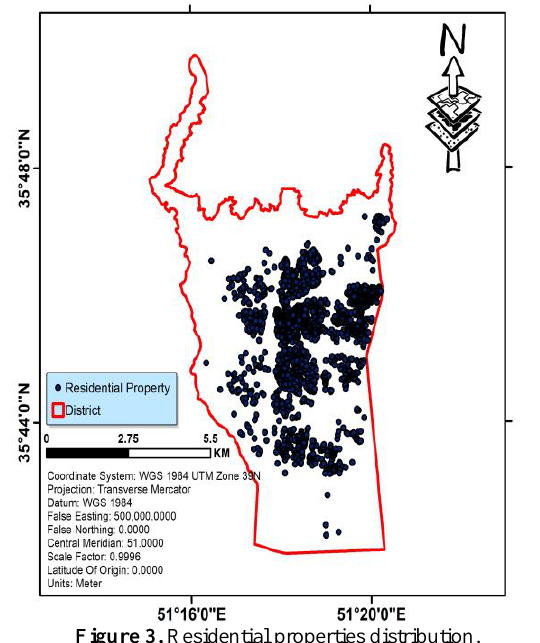
Figure 3. Residential properties